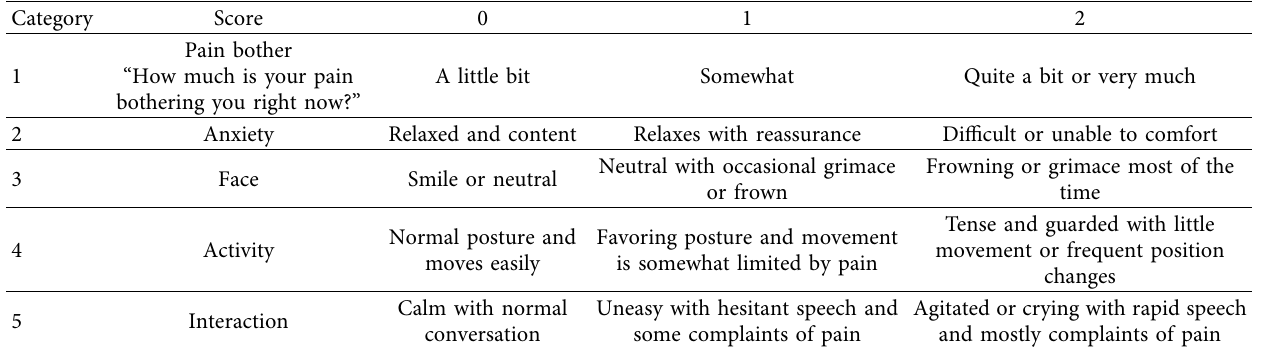
Table 1: Chronic pain behavioral pain scale for adults